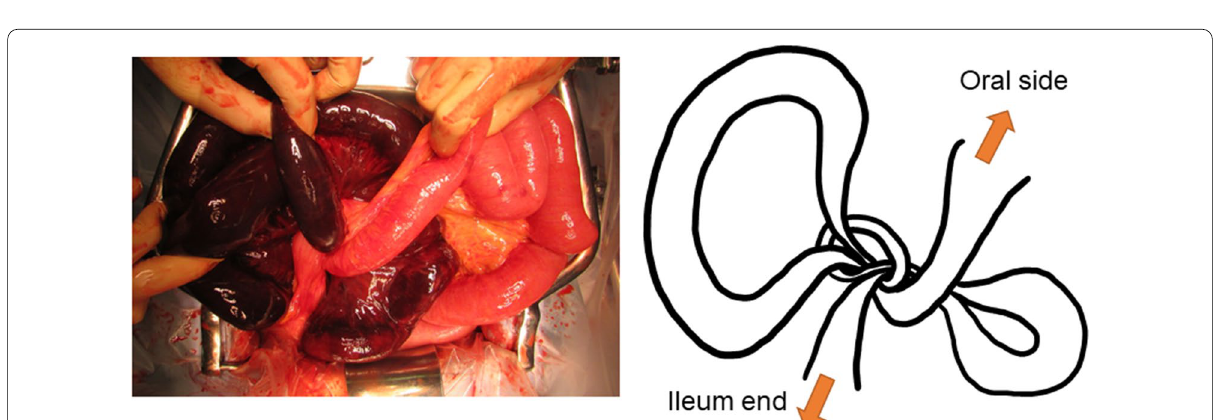
Fig. 2 Intraoperative findings. Two segments of the ileum were tied together to form a knot, and both segments were